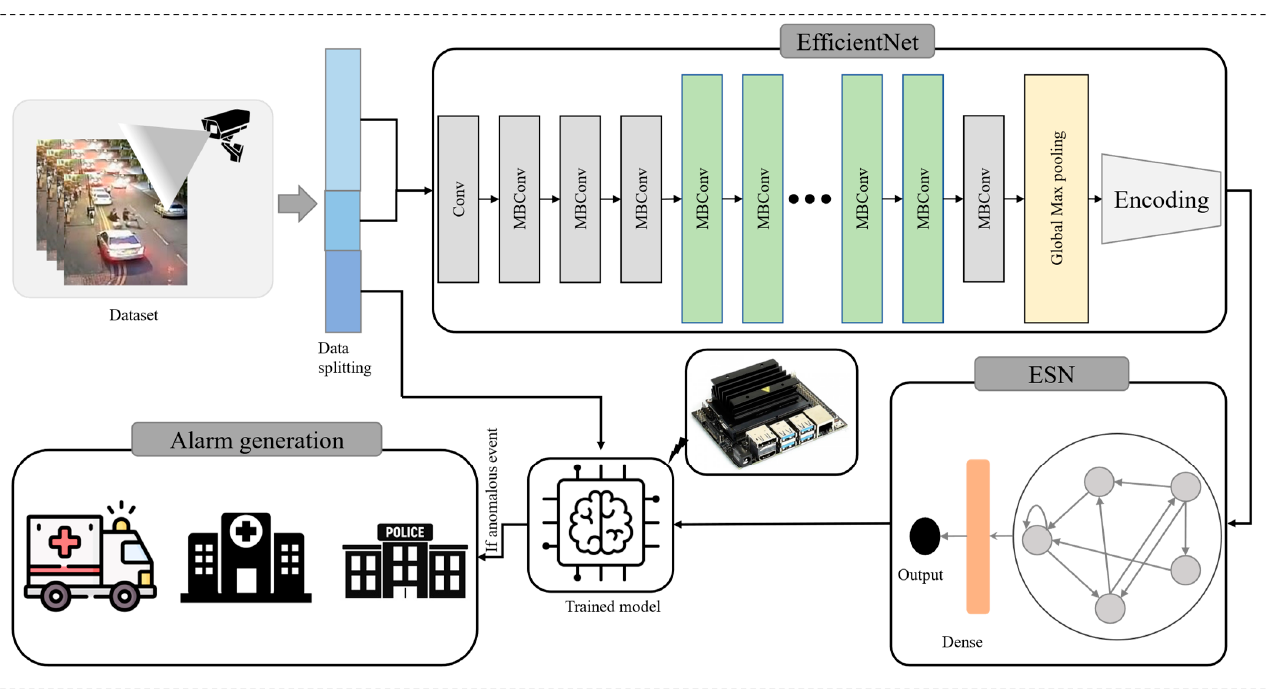
Figure 2. The proposed framework for anomaly detection.